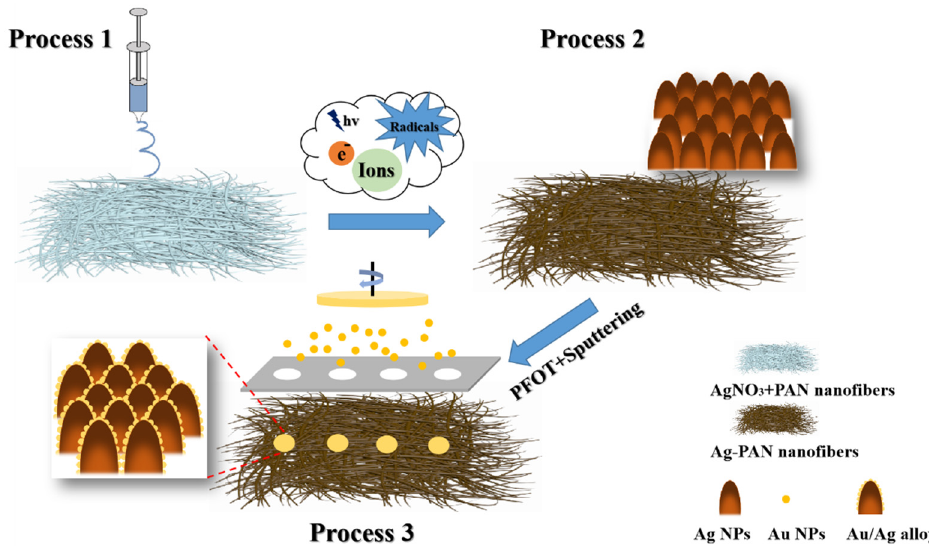
Figure 2. Fabrication of hydrophilic Au/Ag alloy nanocomposites on the hydrophobic Ag-PAN substrate. Process 1: electrospinning porous AgNO 3 -PAN nanofibers substrate. Process 2: Plasma etching process, crystalline Ag NPs were generated after the interaction between metal salts and activated species from plasma groups. Inset showed morphology of Ag NPs on the surface of nanofibers. Process 3: Selective sputtering Au NPs by using homemade masks. In such cases, -F groups were peeled off and then formed Au/Ag alloy nanocomposites, as shown in the inset of Process 3.